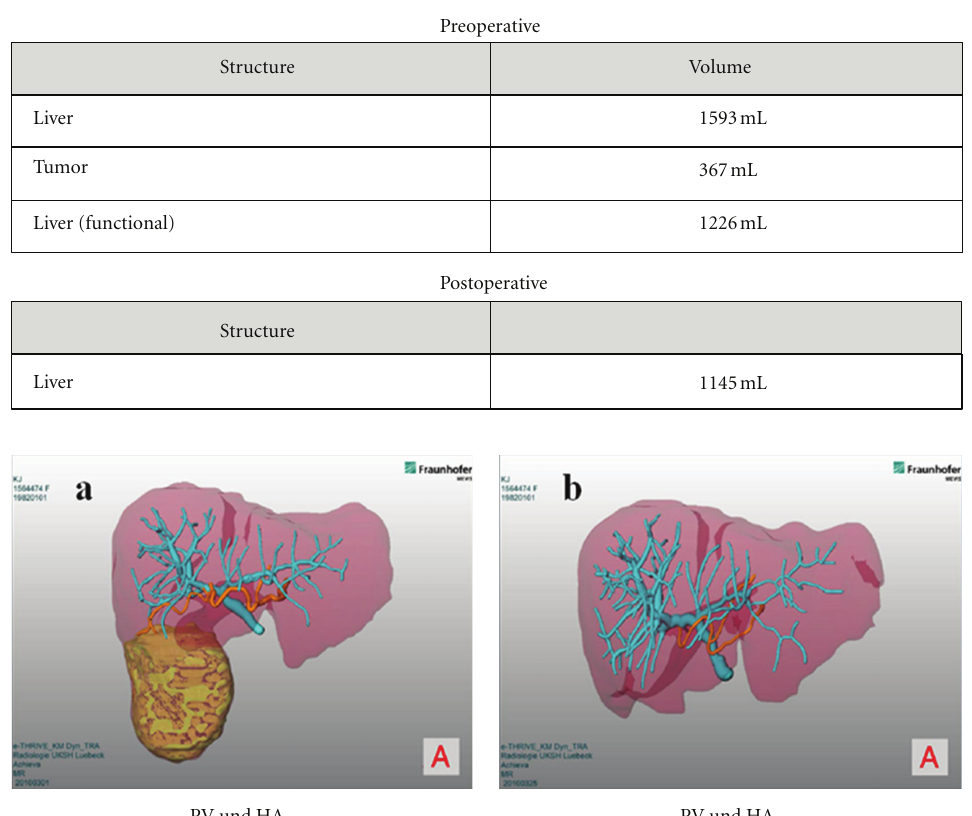
Figure 8: Comparison of pre- and postoperative liver volume. (a) Preoperative 3D presentation of liver with portal venous and arterial vessels and tumor location. (b) Postoperative 3D presentation of liver with portal venous and arterial